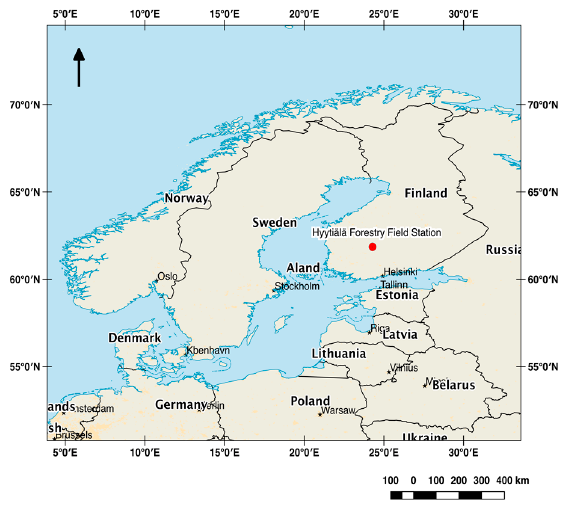
Figure 1. Hyytiälä Forestry Field Centre in southern Finland. Sources: Esri, 2016.